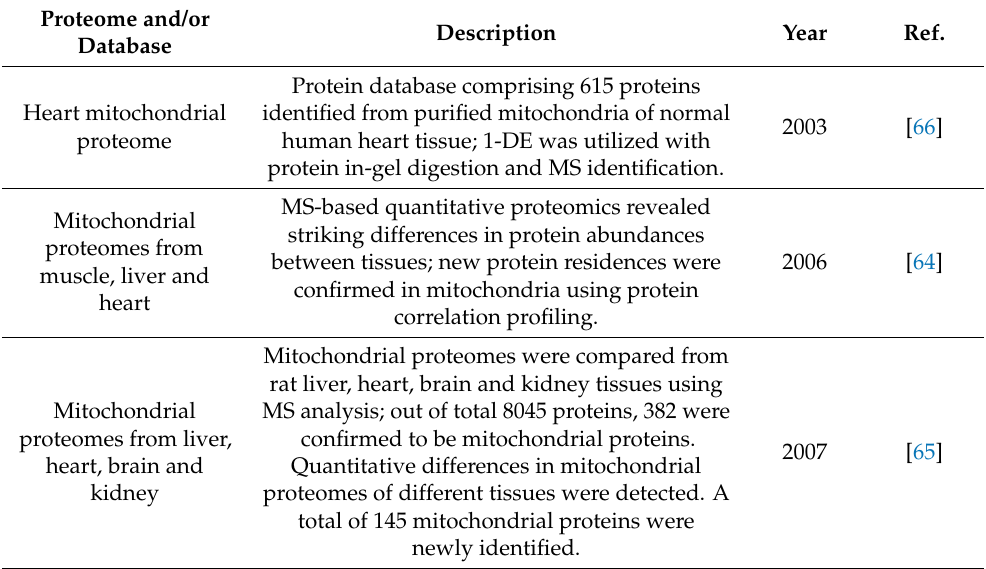
Table 1. Examples of the articles which include datasets of mitochondrial proteins and mitochondrial protein